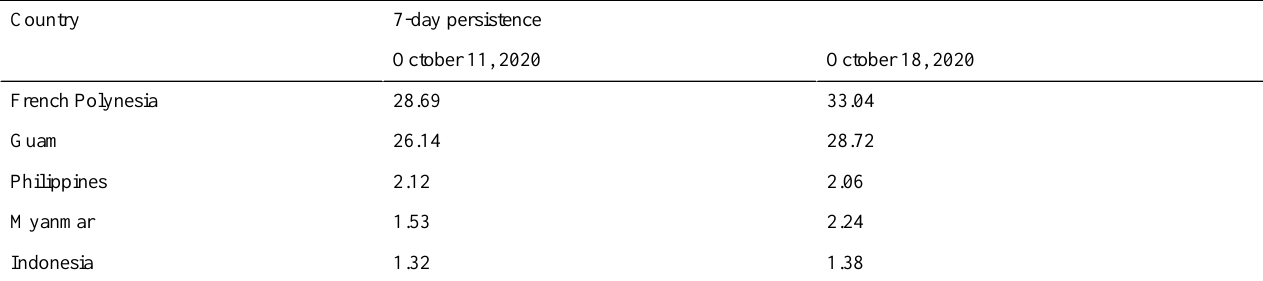
Table 6. Seven-day persistence